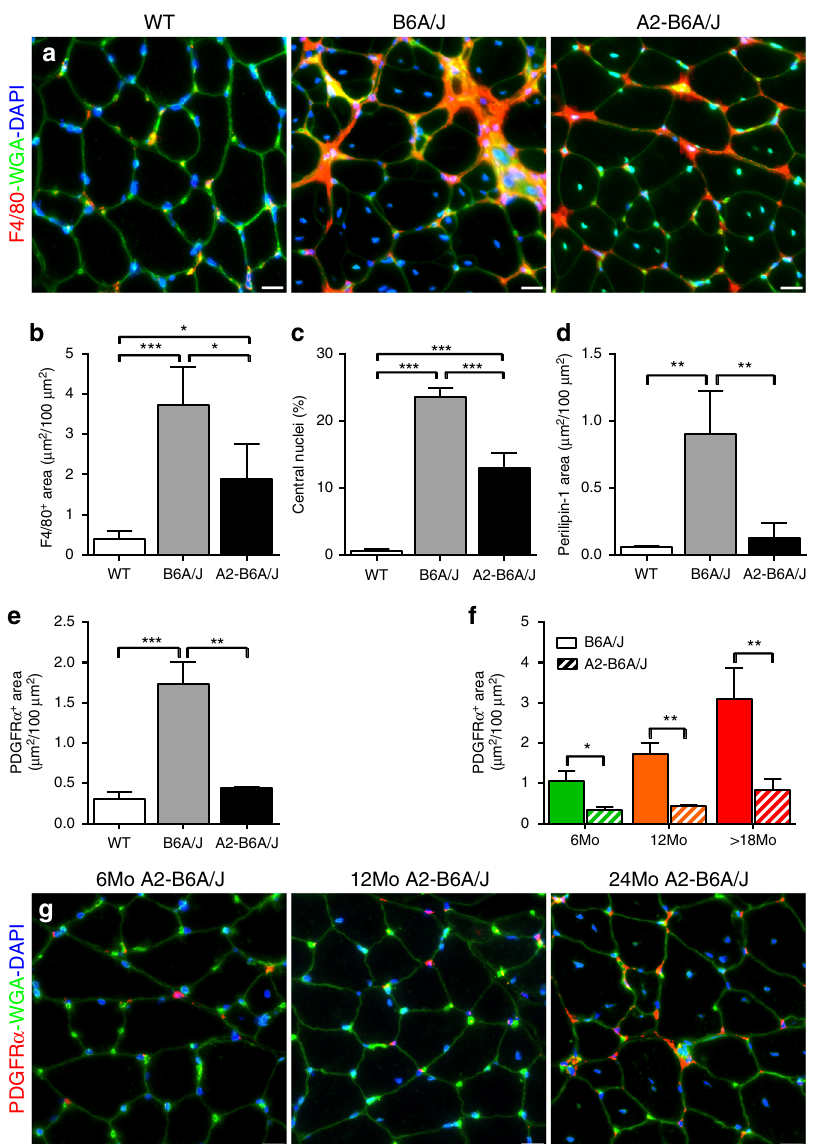
Fig. 5 Presence of AnxA2 is required for adipogenic conversion of dysferlinopathic muscle. a F4/80 staining of gastrocnemius of 12Mo WT, B6A/J and A2- B6A/J. Scale bar = 20 µ m. Quanti fi cation (mean ± SD) of b F4/80 labeled area, c myo fi ber central nucleation, d Perilipin-1 labeled area, and e PDGFR α labeled area from 12Mo WT, B6A/J and A2-B6A/J, n = 4/genotype. Statistical comparisons performed via ANOVA with Holm – Sidak multiple comparisons test to compare all means, * p < 0.05, ** p < 0.01, *** p < 0.001. f Quanti fi cation (mean ± SD) of g PDGFR α -labeled area in 6, 12, and 24Mo A2-B6A/J gastrocnemius (scale bar = 20 µ m) shown in comparison to B6A/J (as presented in Fig. 2f), n = 3 mice/group. Statistical comparisons performed by two- tailed t -test between B6A/J and A2-B6A/J at each timepoint, * p < 0.05, ** p <